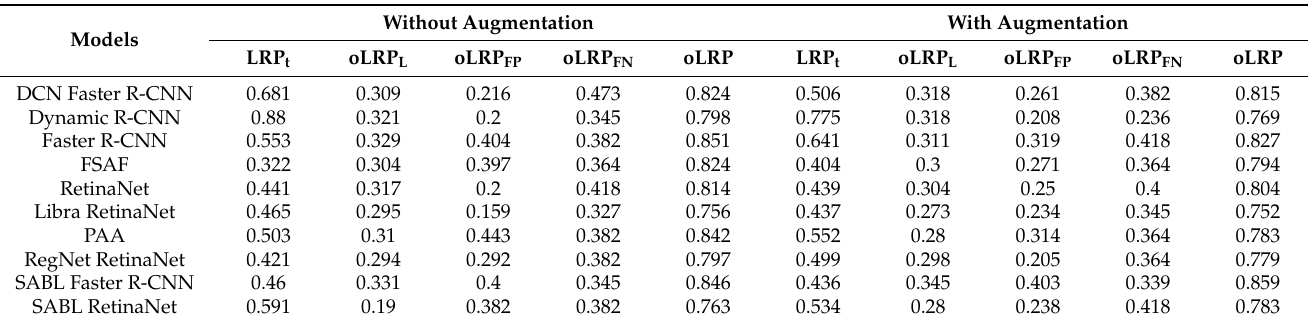
Table 7. Validation LRP-optimal threshold (LRP t ), oLRP Loc (oLRP L ), oLRP FP and oLRP FN results of detection models.